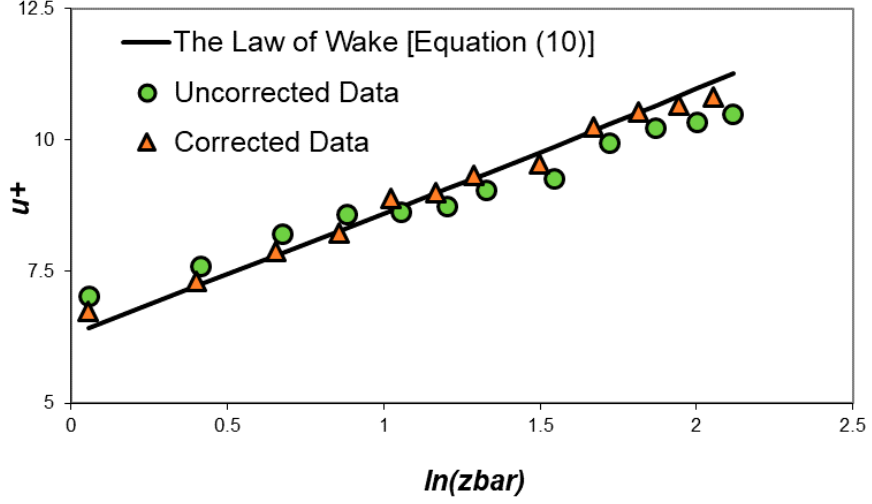
Figure 5. Normalised velocity profile over the sediment transport-induced water-worked bed.